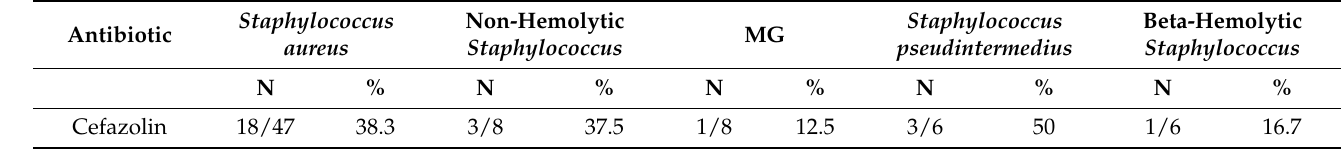
Table 5. Staphylococcal species with intermediate results over the ten-year period